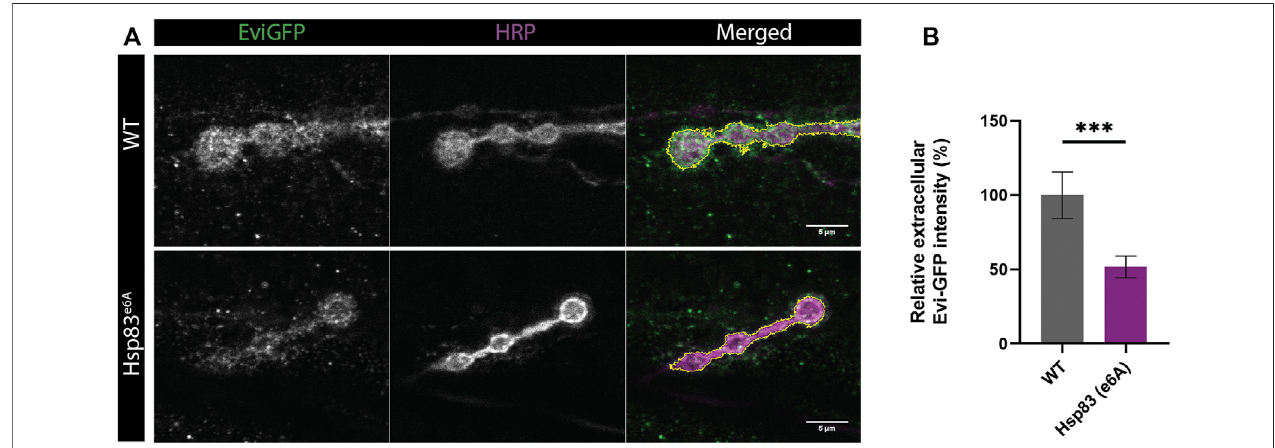
FIGURE 4 | Results obtained using Exoquant macro. (A) Representative images of neuromuscular junction (NMJ) boutons from wild type (WT) and Hsp83 e6A mutants expressing Evi-GFP (green). The presynaptic compartment is labeled with anti-HRP antibody (HRP). Merge image highlights in yellow the presynaptic membrane. (B) Quanti fi cation of exosome release using Exoquant shows lower relative Evi-GFP fl uorescence in Hsp83 e6A mutants compared to wild-type animals. Values were normalized to wildtype. n (cid:2) 18 (wild-type) and n (cid:2) 28 (Hsp83 e6A ) image fi elds per condition. Data were analyzed using a student t-test (two-tailed) for normal distributions. Normality was analyzed with D ’ Agostinothe -Pearson Omnibus test. *** p < 0.001, data shown as mean ± SEM.